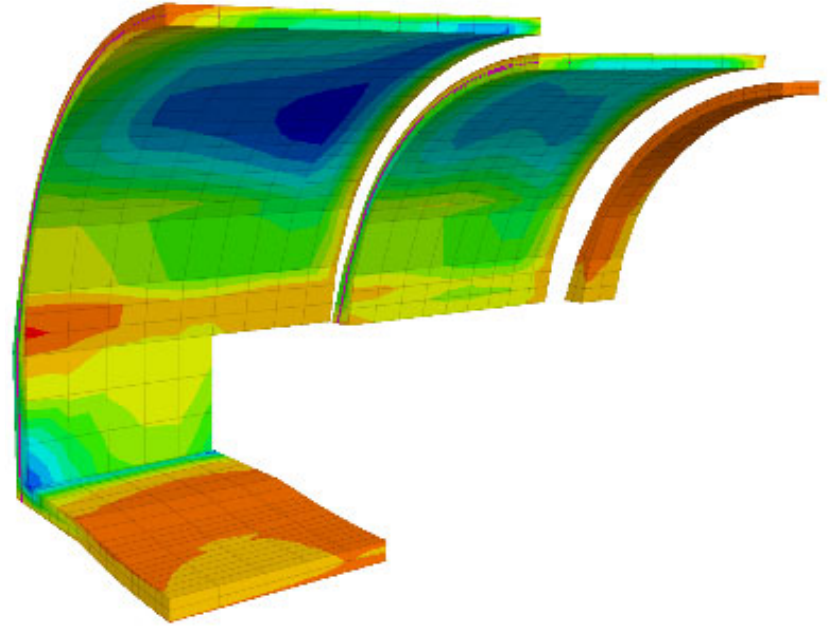
Figure 14. Major principal stress contours, (in N/m 2 ) in concrete elements. Minimum parameters.